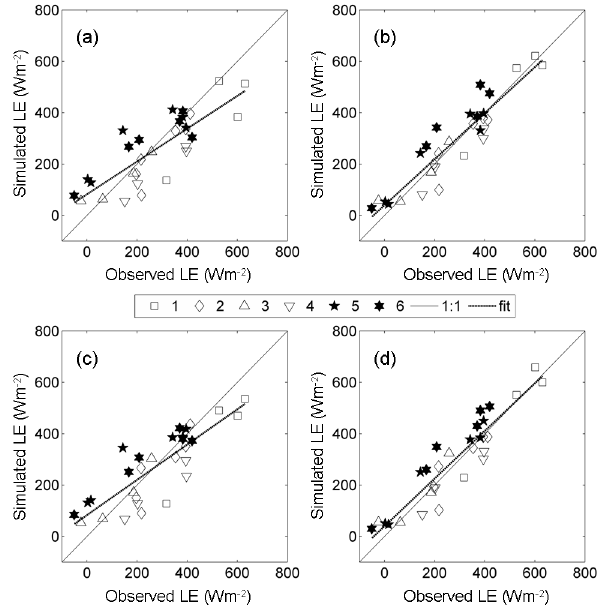
Fig. 7. The ET simulated by the classical T − α space-based ap- proach ( a and c ) and by SEB-1S ( b and d ) using observed available energy is plotted versus station measurements. The top and bottom lines correspond to T v,min = T min and T v,min = T a , respectively.